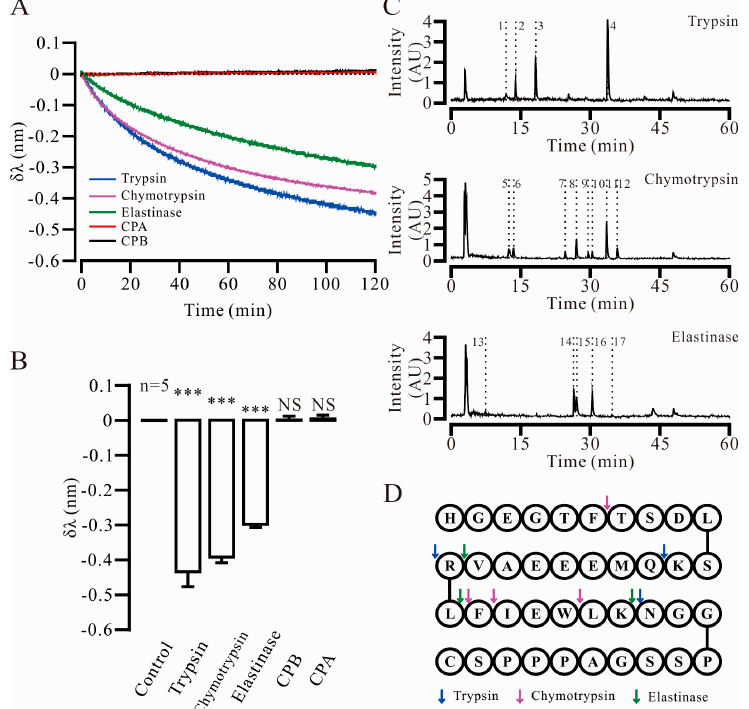
Figure 2. Confirmation of the key proteases and cleavage sites for Exendin4-cysteine (Ex4C) in the small intestine. ( A ) The negative migration of the reflected lights, measured as the change in wavelength in nm, indicated the changing shape of the substrate and the hydrolysis efficiency. ( B ) Bio-layer interferometry data represent five separate experiments. The data are presented as the mean ± SEM, n = 5, *** p < 0.001, NS means no significant difference. ( C ) The molecular weights of the hydrolyzed Ex4C fragments were confirmed by liquid chromatography-mass spectroscopy (LC-MS). Each number represents a fragment analyzed by MS. The analysis is provided in Table 1. ( D ) The amino acid sequence of Ex4C is shown in the figure with the letters. The seven specific cleavage sites for the three proteases were determined by analyzing the fragments and showed in different colors. Table 1. Analysis of the hydrolytic fragments detected by mass spectroscopy (MS). The corresponding fragments and key cleavage sites were determined by comparing the apparent and theoretical molecular weights. The “No.” corresponds to the fragments identified in Figure 2C. Protease No. Retention Time Apparent Molecular Weight Theoretical Molecular Weight Fragment